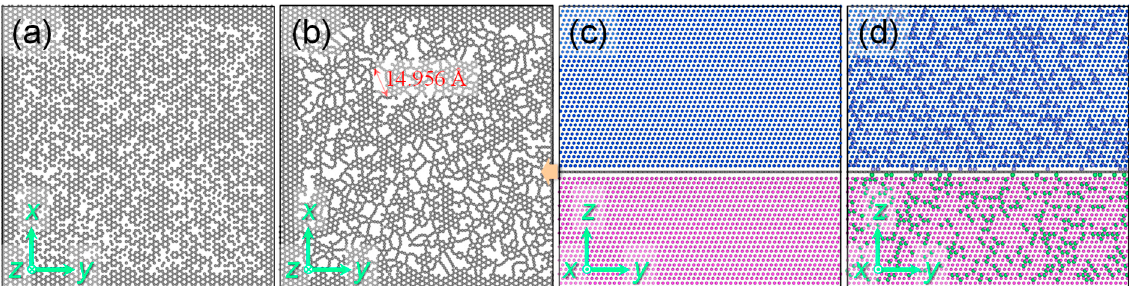
Figure 2. Simulation model for He diffusion. ( a ) Originally atomic configuration of Gr with irradiation-induced defects in NGI. ( b ) Atomic configuration of defective Gr in NGI after static relaxation. ( c ) Atomic configuration of defective NGI after static relaxation. ( d ) Atomic configuration of NGI with a He concentration of 4,970 appm.